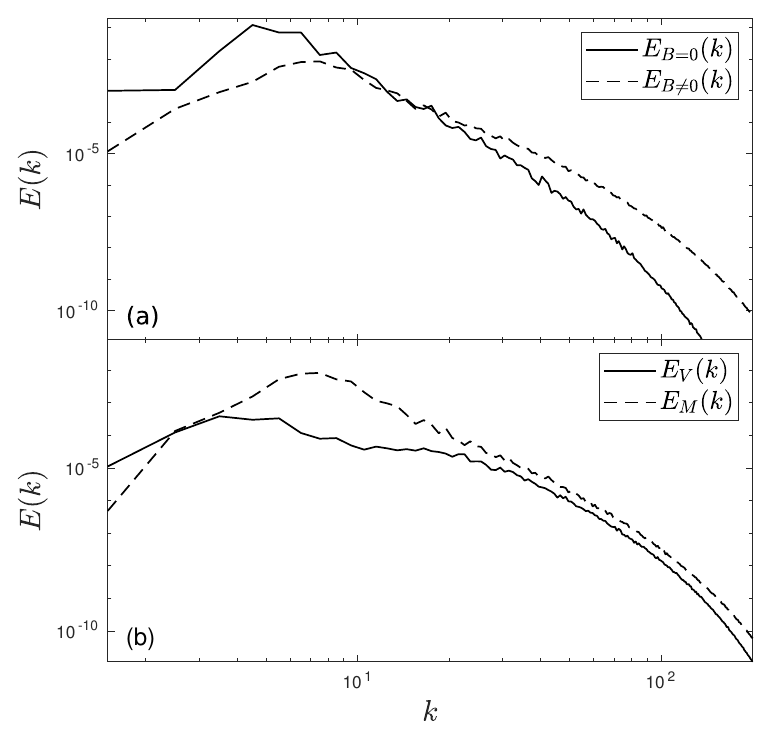
Figure 5. ( a ) Energy spectra of (solid line) the kinetic energy for the neutral fluid E B = 0 ( k ) and (dashed line) the total energy for MHD turbulence E B (cid:54) = 0 ( k ) on the β -plane ( β = 10). ( b ) Energy spectra of (solid line) the kinetic energy and (dashed line) magnetic energy for MHD turbulence on the β -plane ( β = 10). All spectra are given for the time T (cid:39) 2 T 0